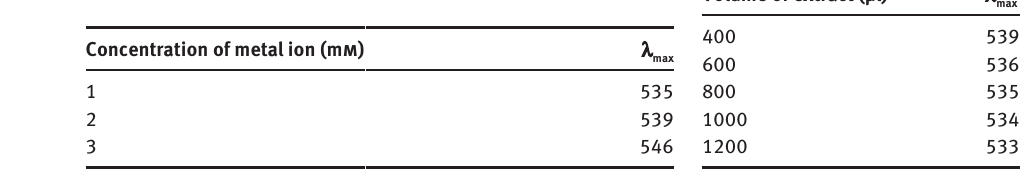
Table 1 Influence of metal ion concentration.